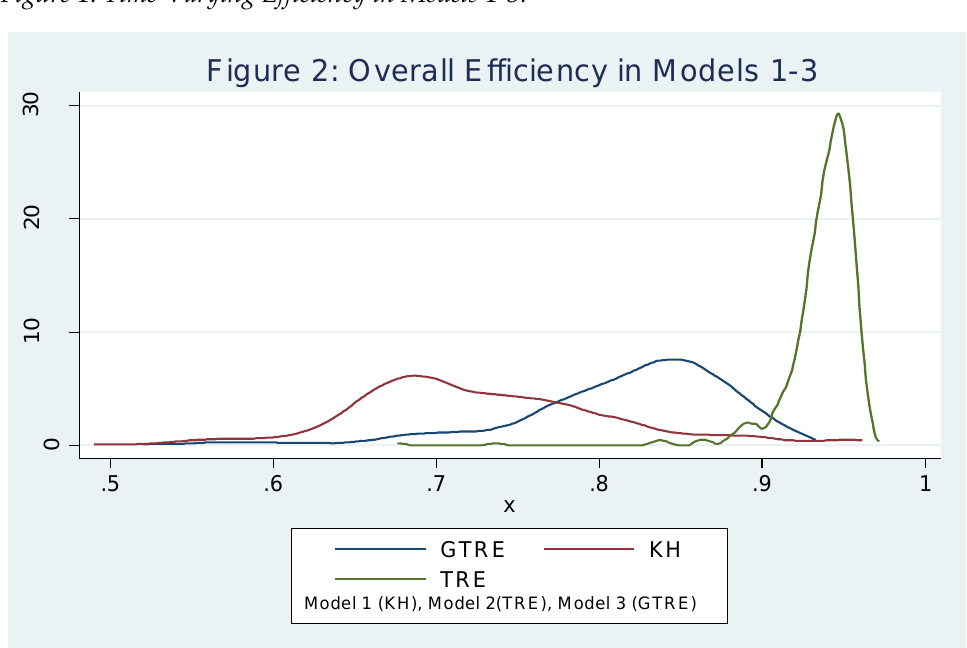
Figure 2. Overall Efficiency in Models 1-3.